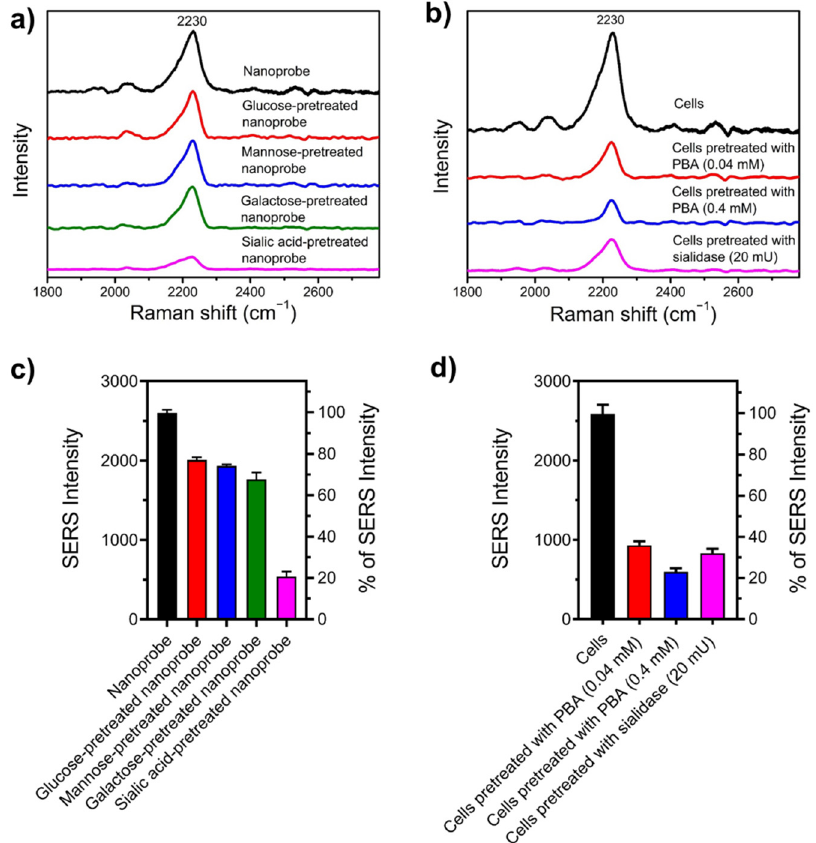
Figure 4 . ( a ) SERS spectra resulting from the HeLa cells that were incubated with monosaccharide- pretreated nanoprobe. ( b ) SERS spectra of nanoprobe incubated with HeLa cells, HeLa cells pre- treated with 0.04 mM PBA, HeLa cells pretreated with 0.4 mM PBA, and HeLa cells pretreated with 20 mU of sialidase. ( c , d ) Bar graphs displaying corresponding intensities of SERS spectra from ( a , b ), respectively. λ = 532 nm, 0.78 mW, 100× objective lens, exposure time of 5 s.